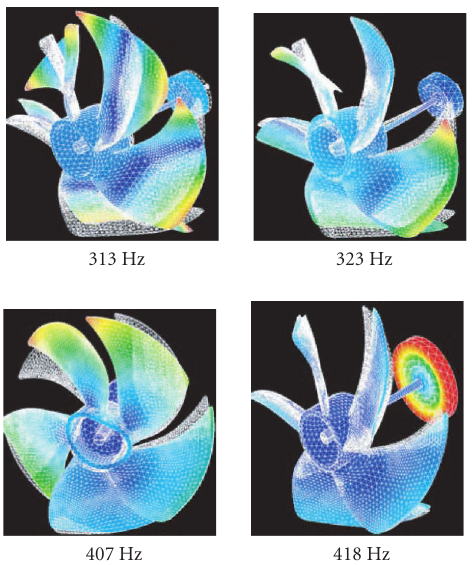
Figure 7: Mode shapes of the whole shaft